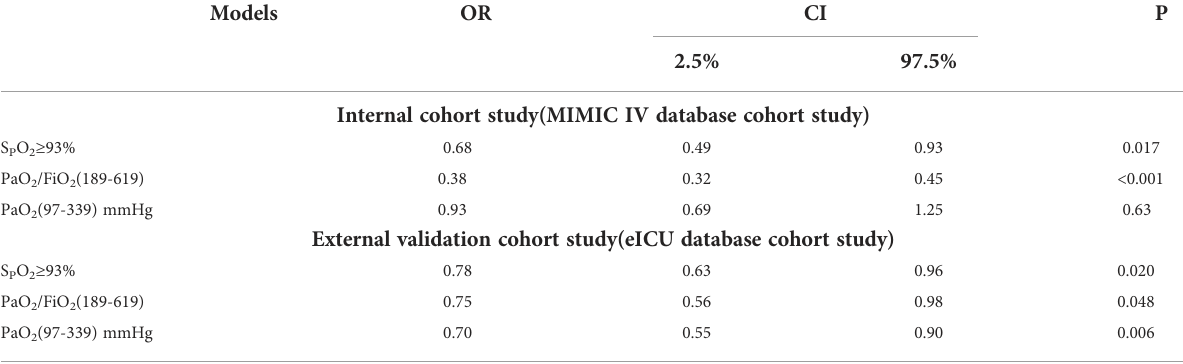
TABLE 3 Multiple COX regression model analysis of blood oxygen index to hospital mortality in sepsis with encephalopathy. Models